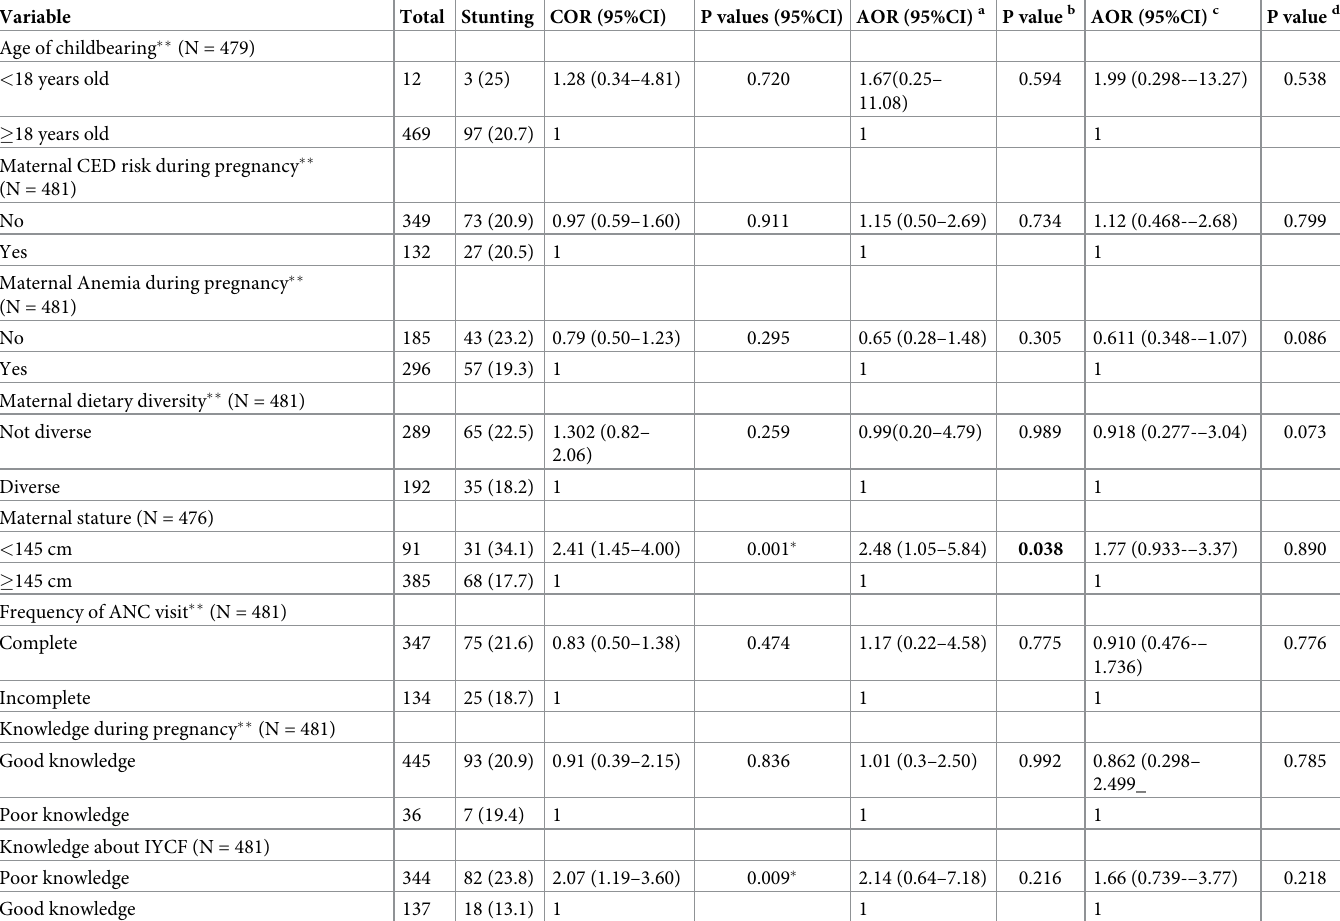
Table 4. Mother/caregiver characteristics and